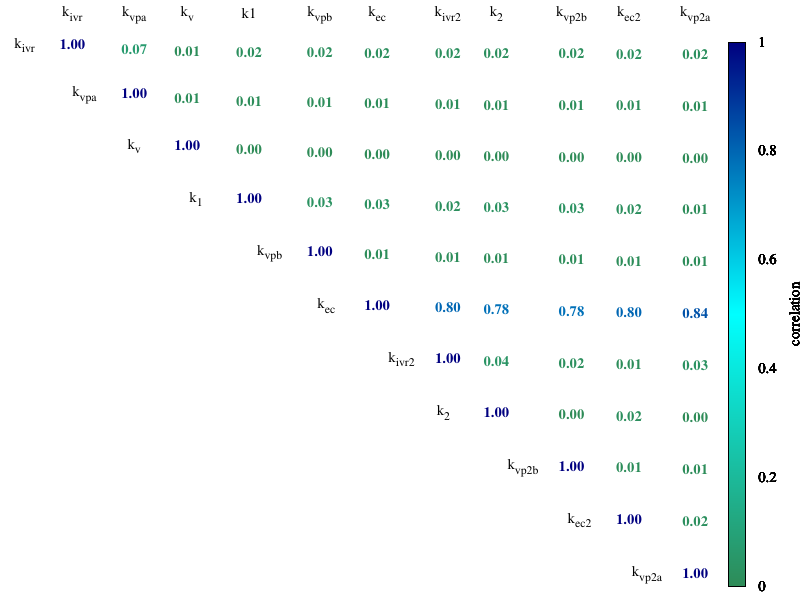
Figure 9. Correlation matrix for vibrational level v =